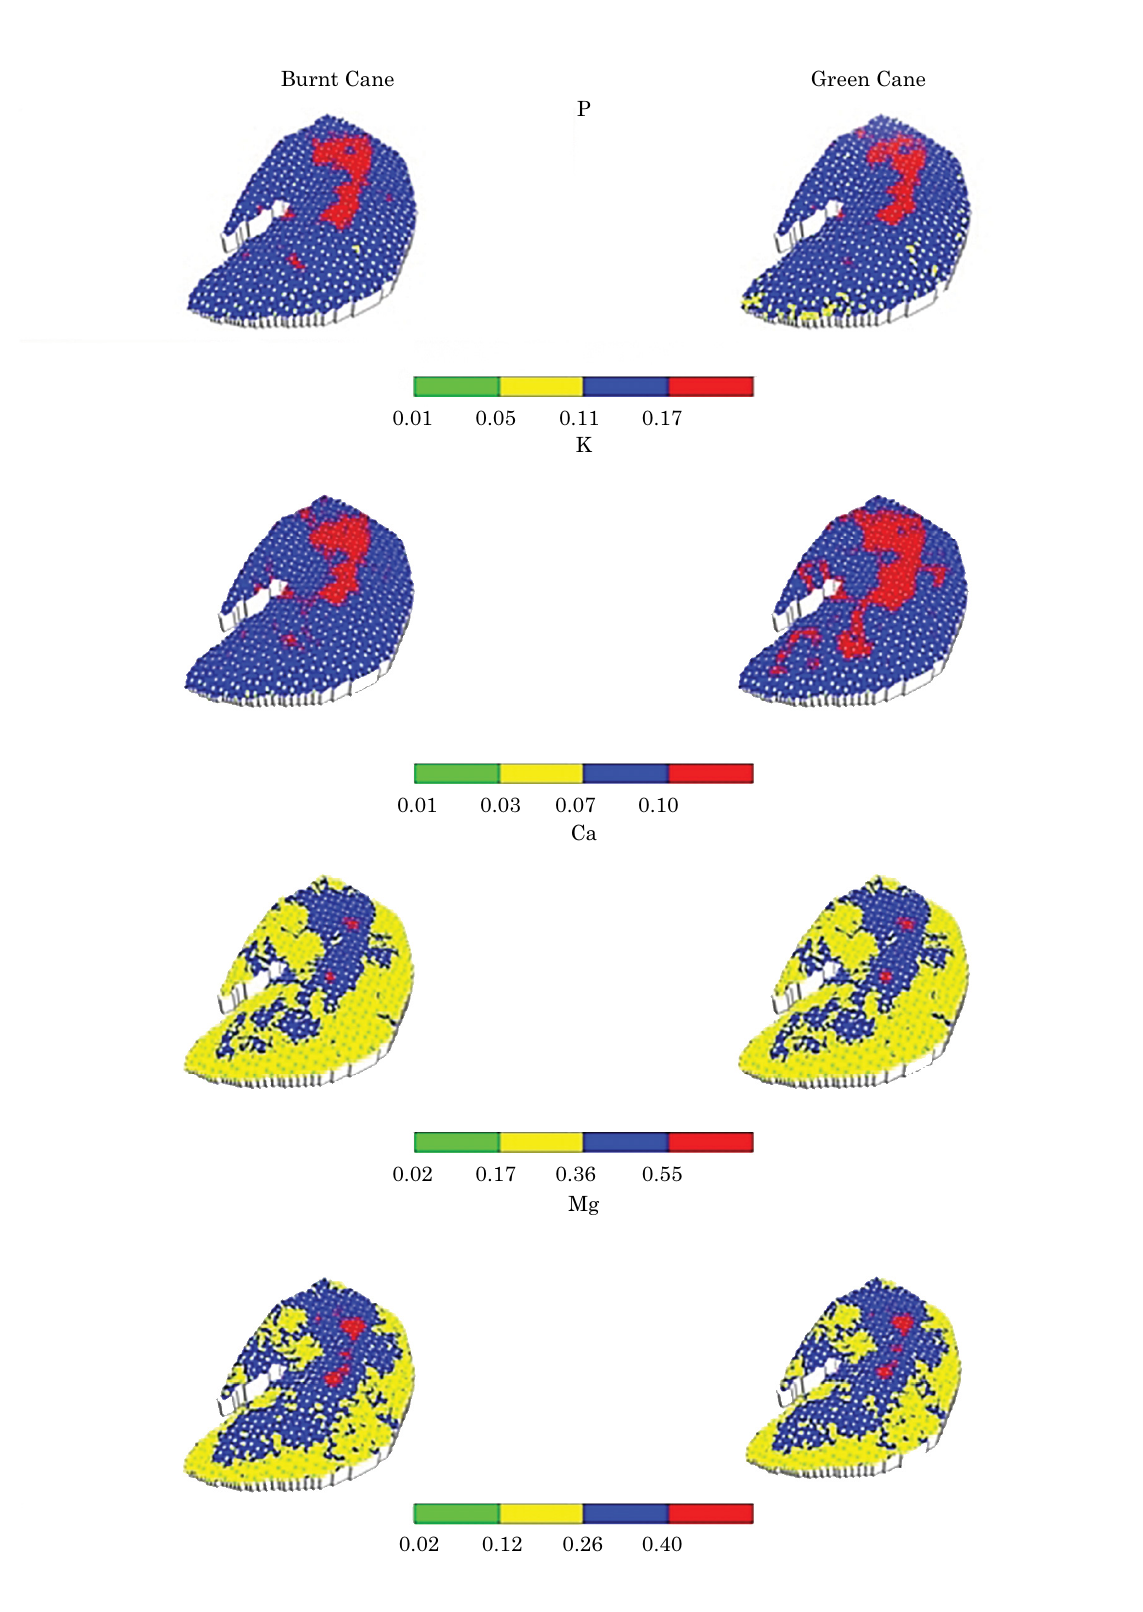
figure 3. Standard deviation estimates of p, K, ca, and Mg soil depletion rates in burnt and green sugarcane harvest